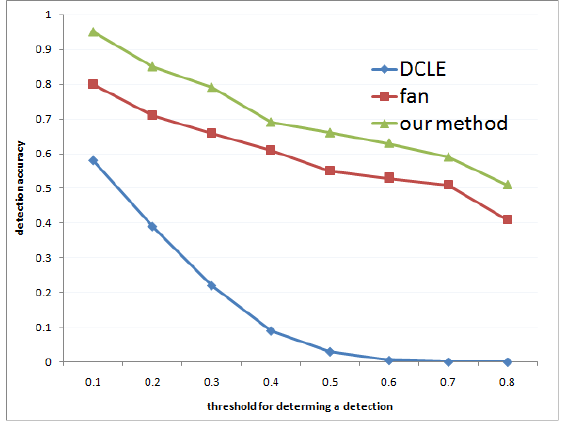
Figure 8. Accuracy of the methods. The horizontal axis shows the threshold for determining a detection, and the vertical axis shows the detection